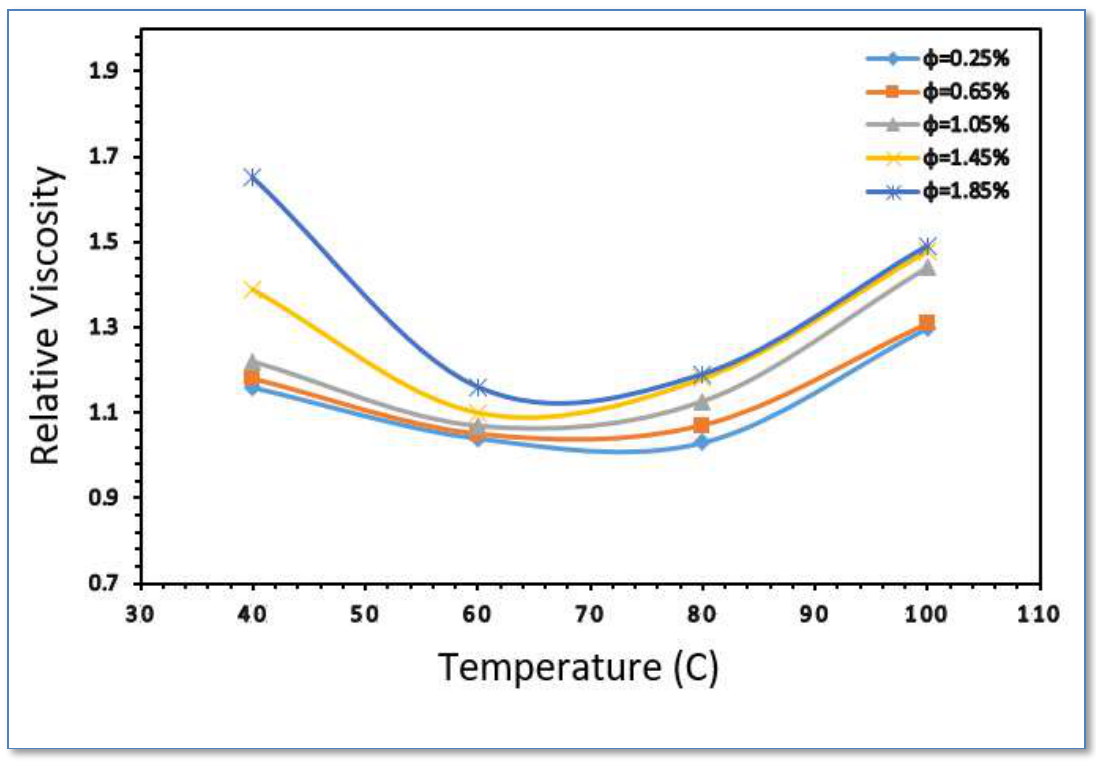
Figure 9: Relative viscosity of Al 2 O 3 nano-lubricant versus temperature in various mass